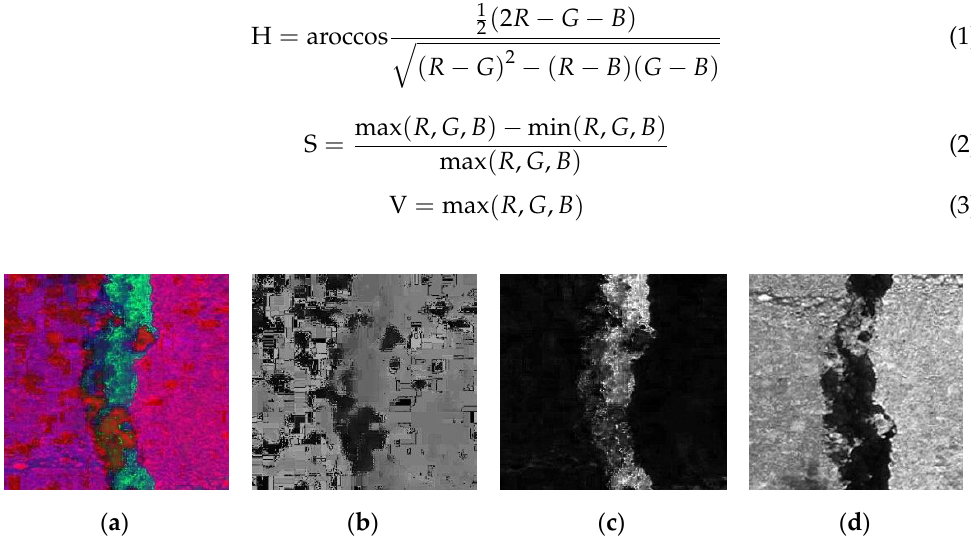
Figure 1. Converting the crack image to HSV, where ( a ) results from the pseudo-color operation. The sub-components are ( b ) H, ( c ) S, and ( d ) V. sub-components are ( b ) H, ( c ) S, and ( d )